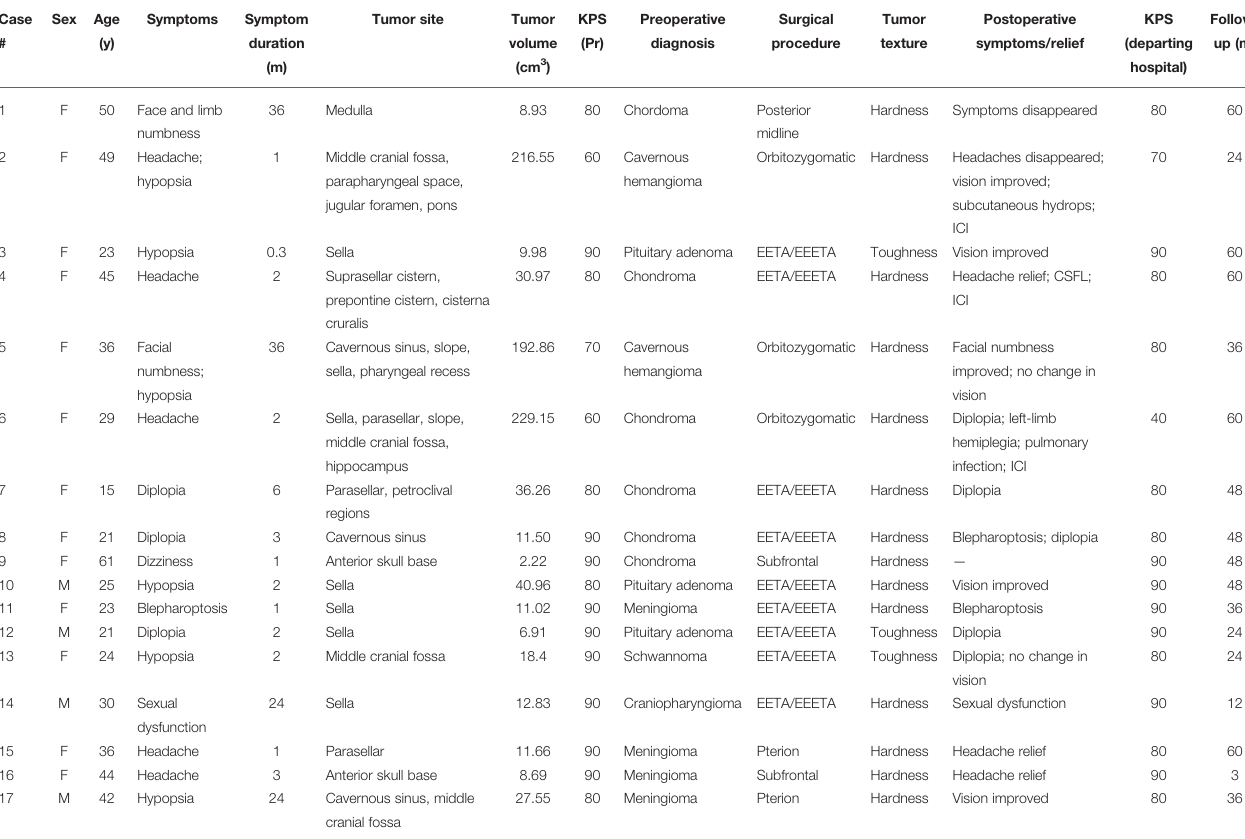
TABLE 1 | Seventeen patients treated for intracranial chondroma between January 2010 and November